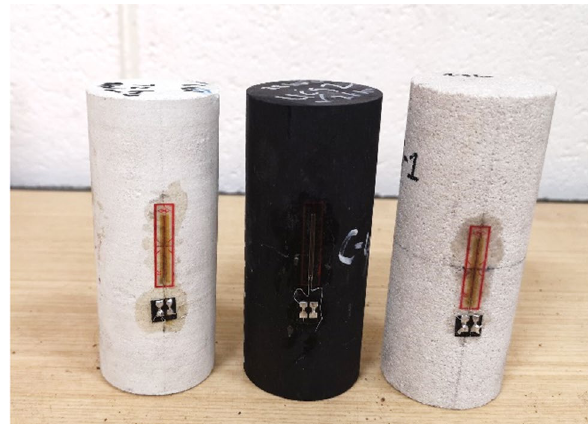
Fig. 6 Prepared samples of coal, Gasford sandstone and Tuffeau lime-